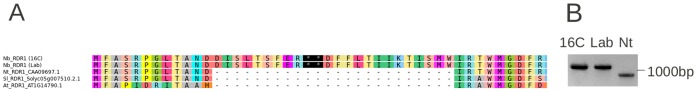
Insertion in the RDR1 sequence of N. benthamiana.(A) Alignment of the RDR1 sequence from two lines of N. benthamiana (Nb) (16C and Lab), N. tabacum (Nt), S. lycopersicum (Sl) and A. thaliana (At). Only the Nb lines possess an insertion containing two stop codons. (B): PCR of region flanking the 72 base insert in Nb 16C and Lab lines, and Nt, indicating that the insertion is only present in N. benthamiana.